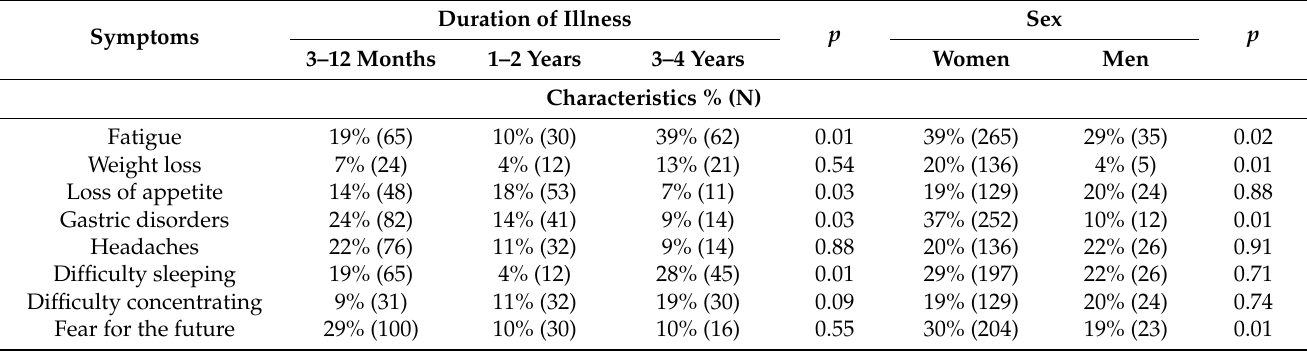
Table 3. Symptoms